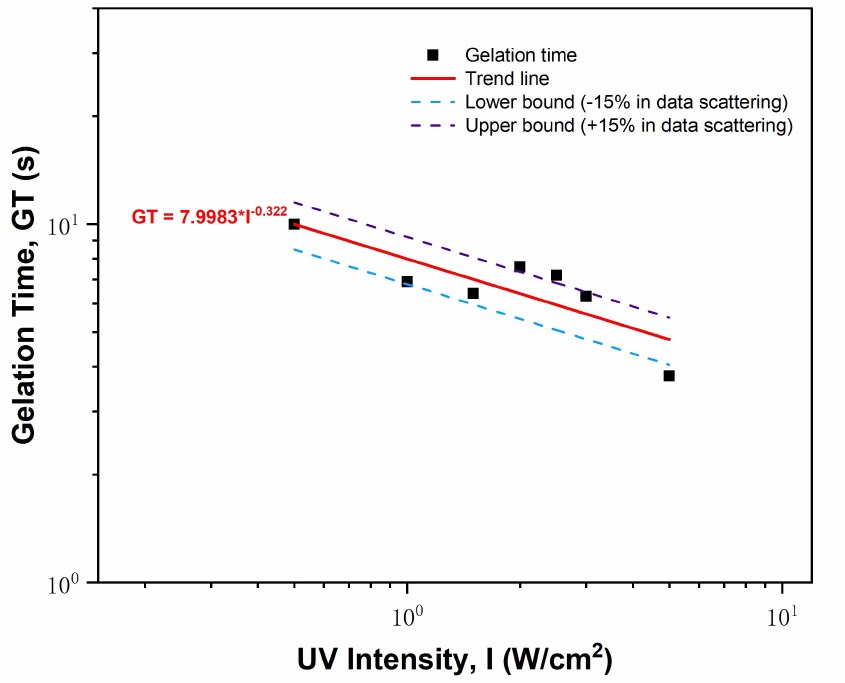
Figure 5. The relationship between gelation time and UV